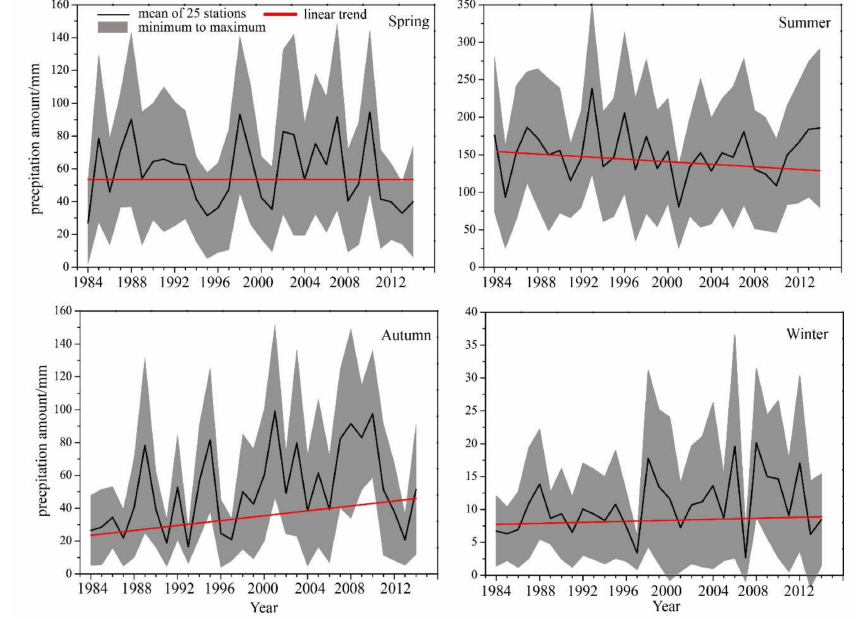
Figure 5. The mean precipitation amount variations of 25 stations in HRB for the spring (March to May), summer (June to August), autumn (September to November), and winter (December to February), respectively, from 1984 to